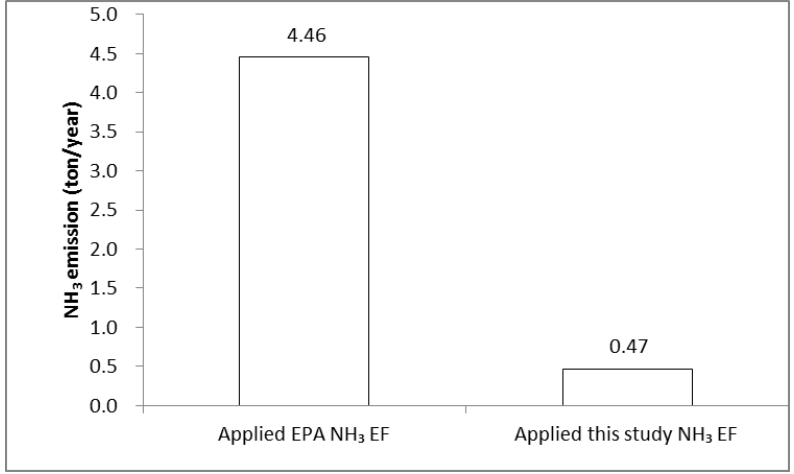
Figure 4. The comparison of NH 3 EF (Emission Factor) for NH 3 emissions at LNG power plants.